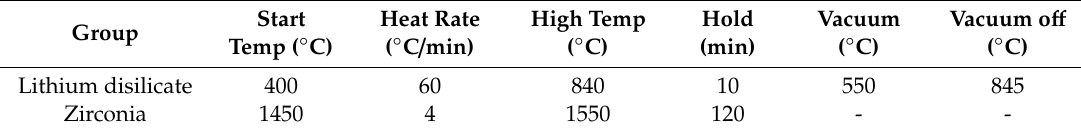
Table 2. Post milling procedure of the lithium disilicate and zirconia.